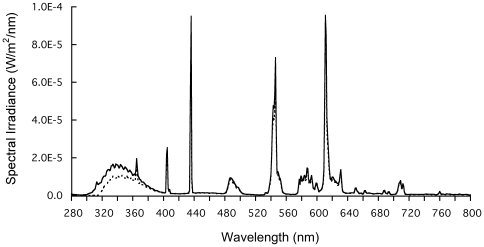
Spectral irradiance at the surface of the water in the tanks in which cod larvae (Gadus morhua) were exposed.Solid line denotes the UV-B treatment and dotted line denotes Control. UV-B wavelengths (280–320 nm) were blocked by Mylar-D film in Control.